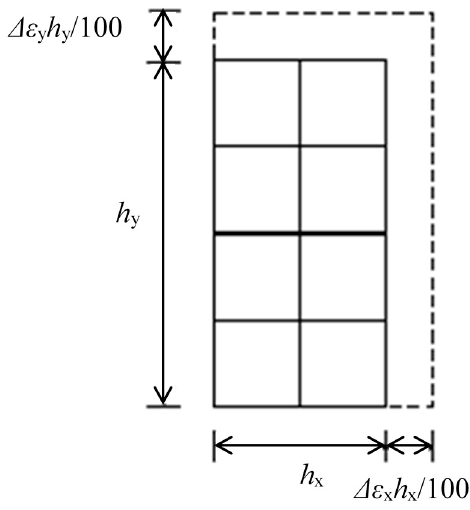
Figure A1. Distortion increasing rate.